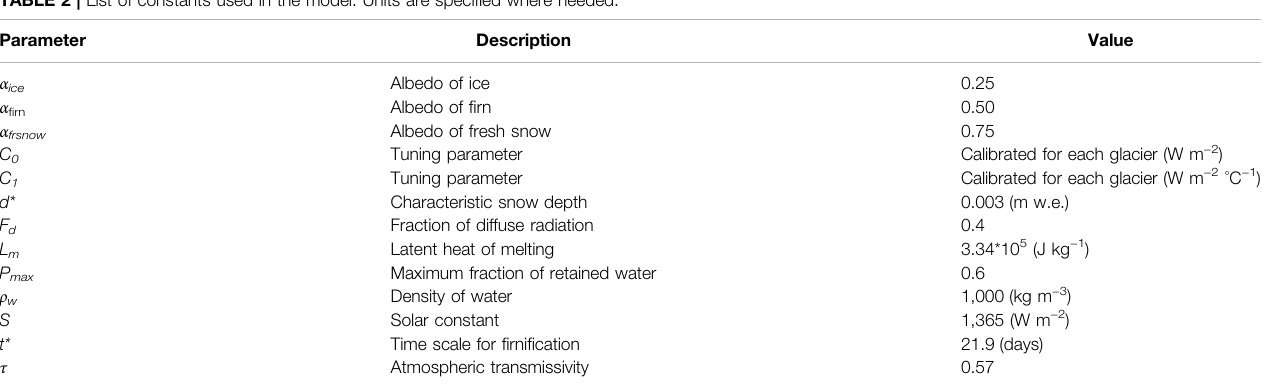
TABLE 2 | List of constants used in the model. Units are speci fi ed where